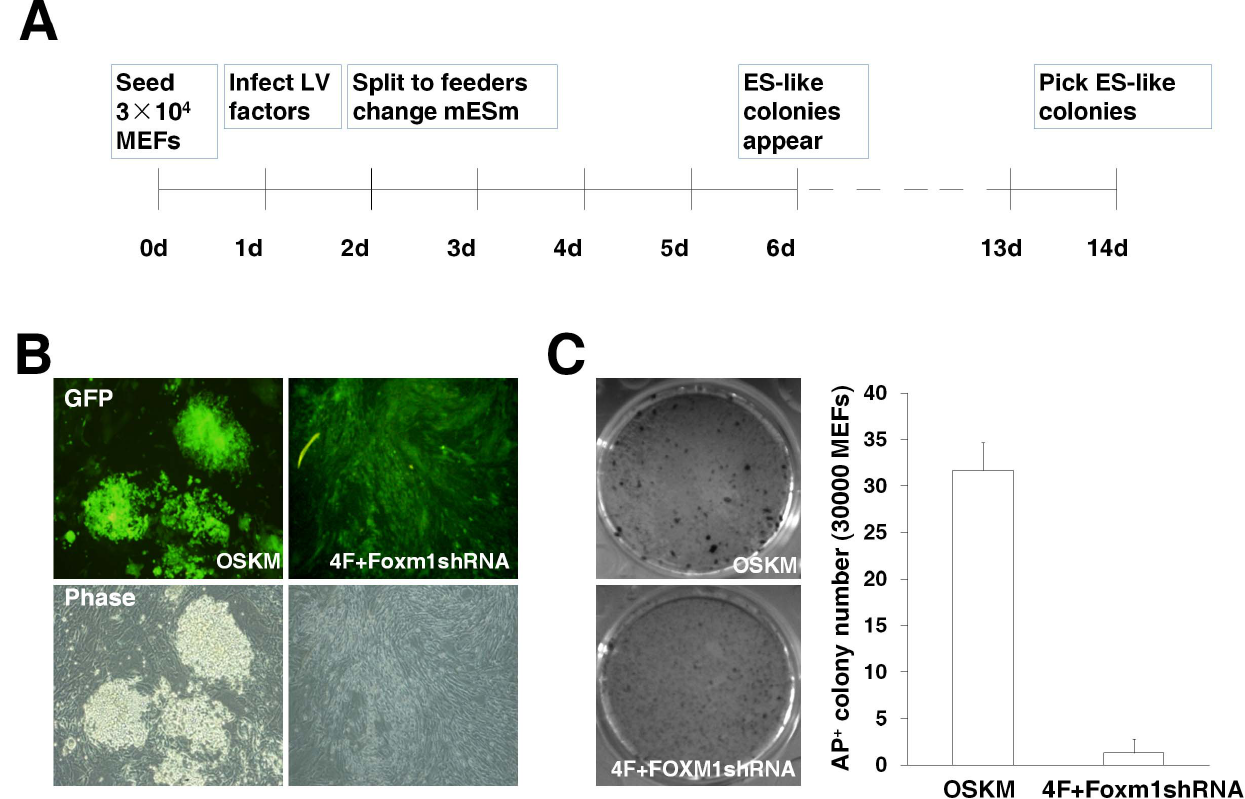
Figure 5. Foxm1 is essential for the reprogramming of somatic cells into pluripotent cells. (A) The procedure of iPCS induction with the infection of a cocktail of lentiviral vectors. (B) The knockdown of Foxm1 expression prevented the formation of iPSCs. MEFs (3 6 10 4 cells) were infected by four lentiviruses that expressed Oct4, Sox2, Klf4, and c-Myc respectively (OSKM). The lentiviral vector expressing Foxm1-specific shRNA was coupled with the infection of OSKM four factors during iPSC formation. Fluorescent and light microscopy images were taken at day 10 of the iPSC formation. (C) Alkaline phosphatase staining of MEFs infected by OSKM or the four factors coupled with the Foxm1 shRNA lentivirus was performed at day 14 post lentiviral infection and the alkaline phosphatase positive (AP + ) colony numbers were counted.